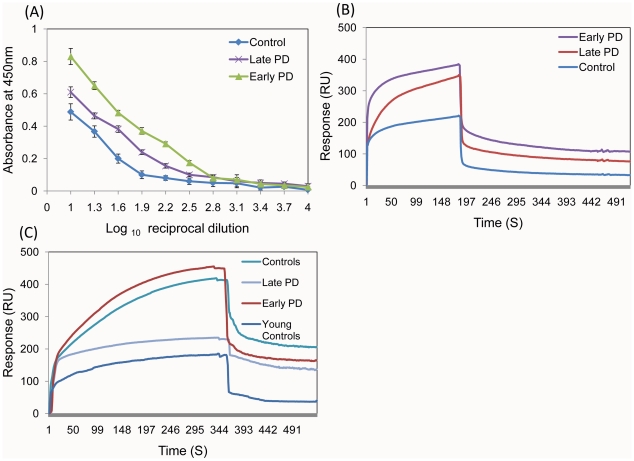
Interaction of α-synuclein species with the sera antibodies of PD patients and controls.ELISA titration curves corresponding to the interactions of monomeric α-synuclein with IgGs from the blood sera of representative control, early PD and late PD individuals as denoted in the caption (A). Biacore sensorgrams reflecting the biding of α-synuclein monomer (B) and fibrils (C) with IgGs from the pooled sera of control, young control (C), early PD and late PD individuals as denoted in the captions.